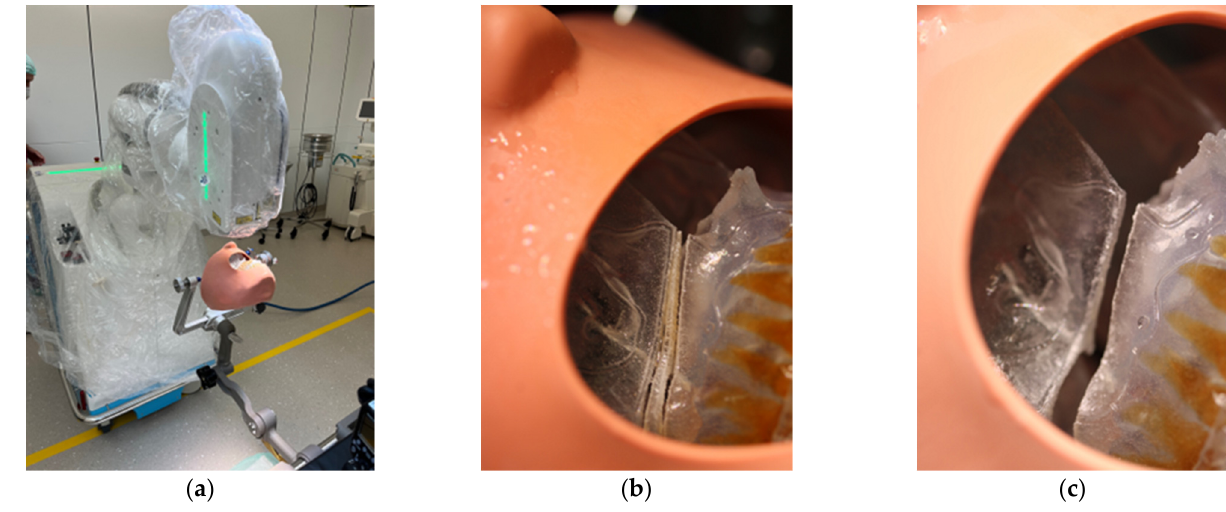
Figure 6. Clinical set-up of the trial surgery with 3D printed patient skull attached to the Mayfield clamp and positioning of the CARLO ® ( a ). Representation of the right osteotomy lines after completion of the laser osteotomy ( b ) and after removal of the “bony” wedge ( c ).